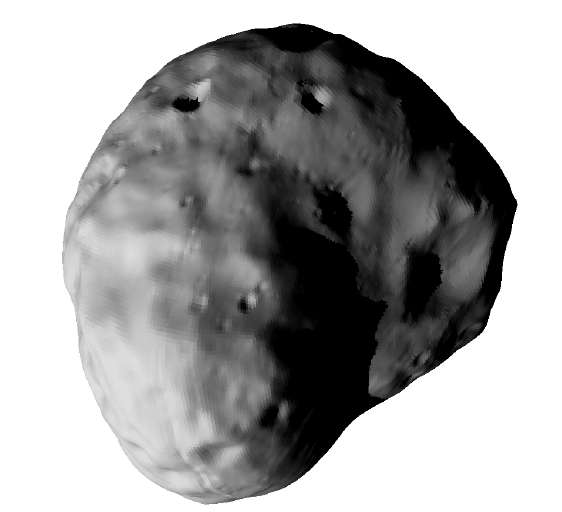
Figure 9. Solar illumination of Martian moon Phobos [17], showing realistic shadowing e.g., of craters.